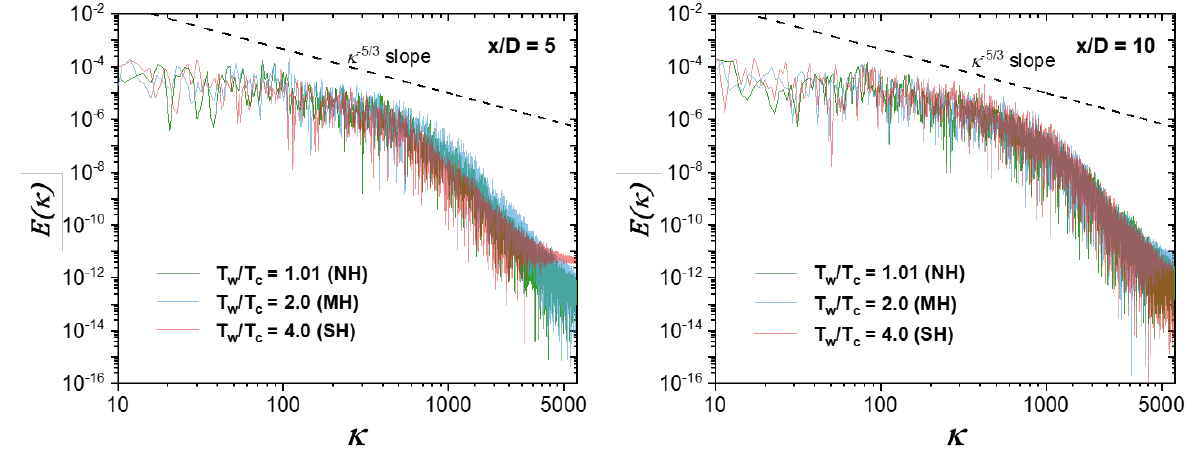
Figure 7. Energy Spectra obtained with different heating loads at x/D = 5 and 10.